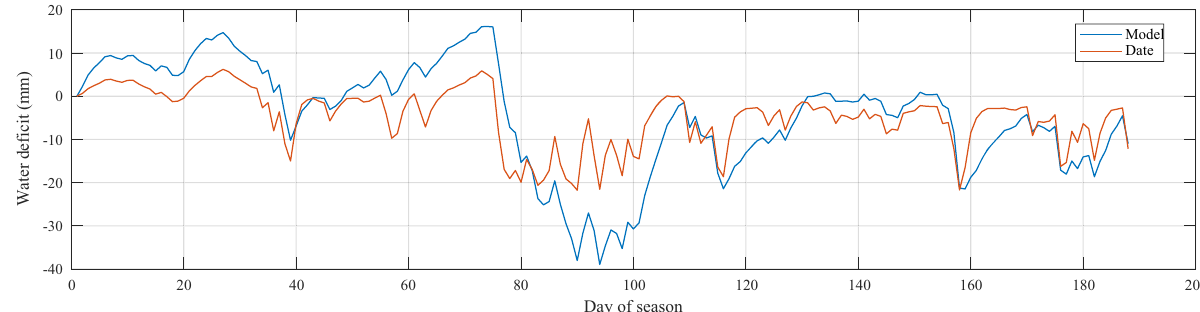
Figure 6: Model fi t and data for data from the Year